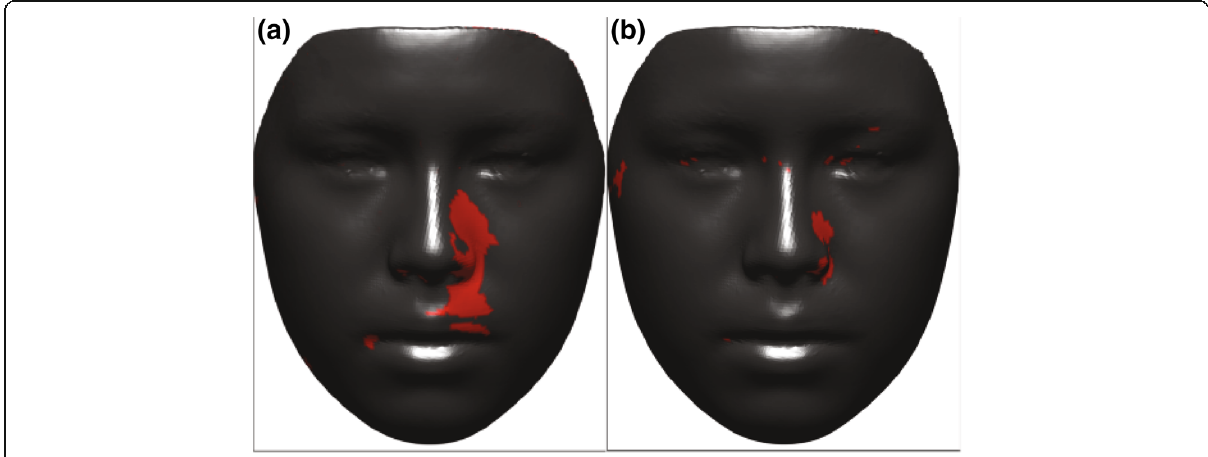
Fig. 9 P-maps between T0 (initial, right before MSE placement) and T1 (immediately after expansion) time points for left side expanded group only with p < 0.05 ( a ) and p < 0.01 ( b )